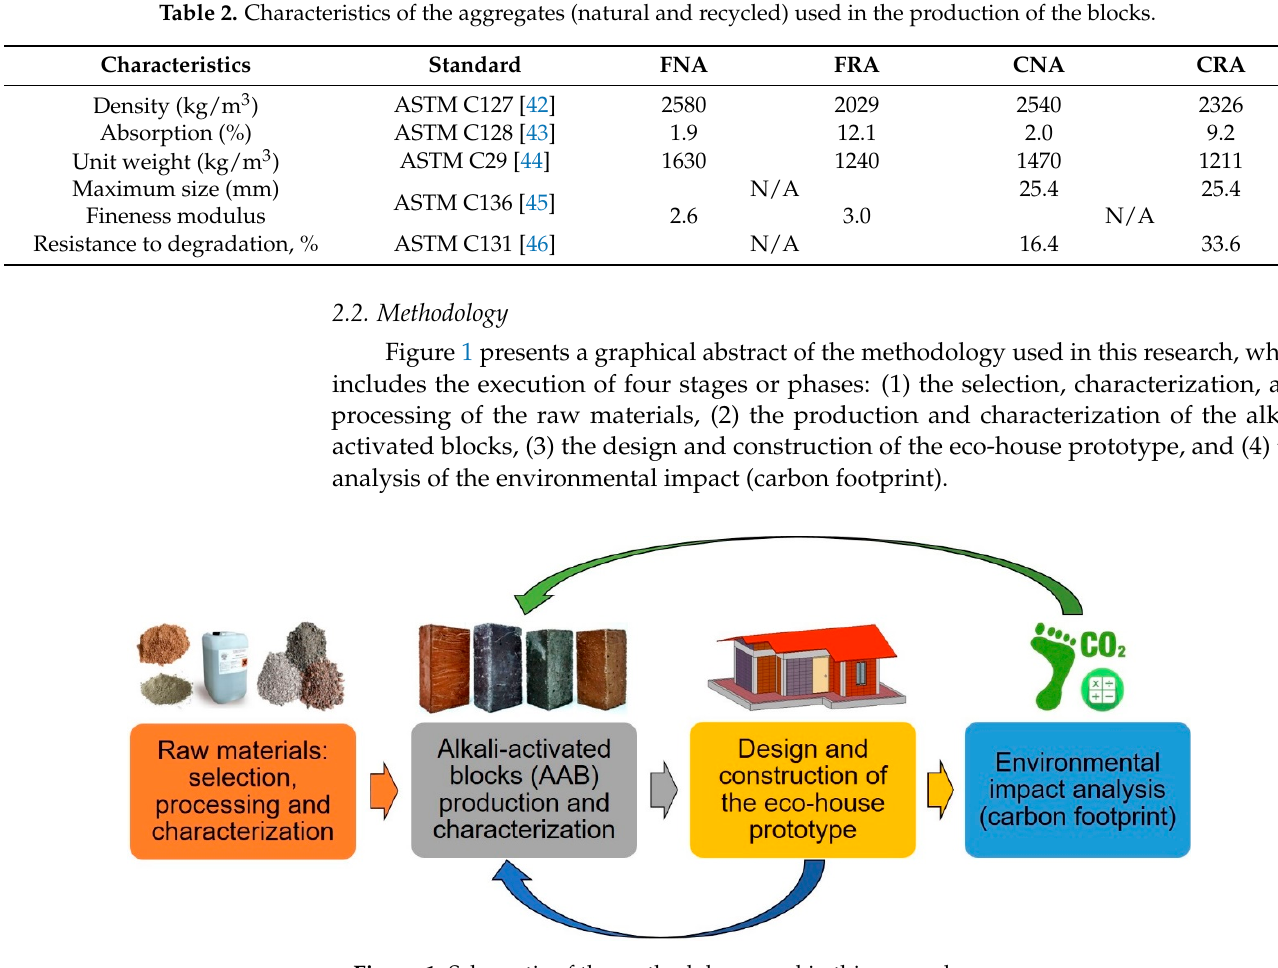
Figure 1. Schematic of the methodology used in this